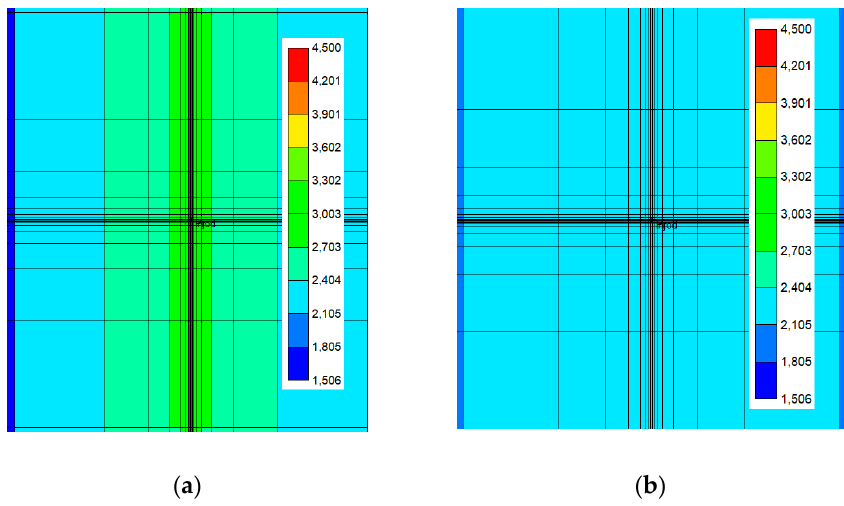
Figure 19. Pressure distribution near the fracture, injection pressure: 3000 psi; ( a ) start of soaking time; ( b ) end of soaking time.